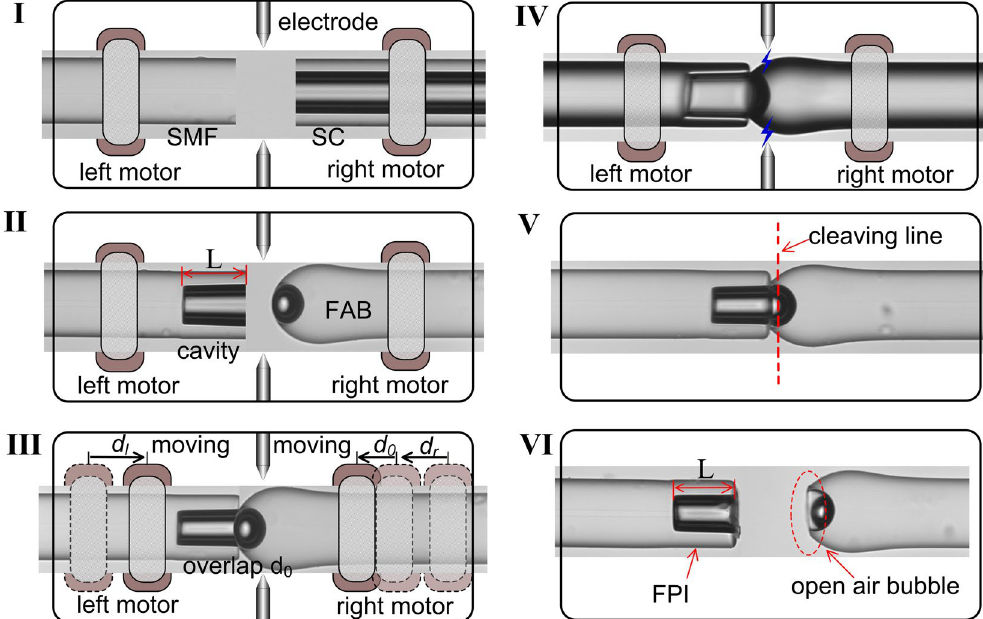
Figure 1. Schematic diagram of the fabrication process for an FPI-based gas pressure sensor employing an FDC using electrical arc discharge in conjunction with single mode fiber (SMF), silica capillary (SC), and fiber-tip air bubble (FAB)